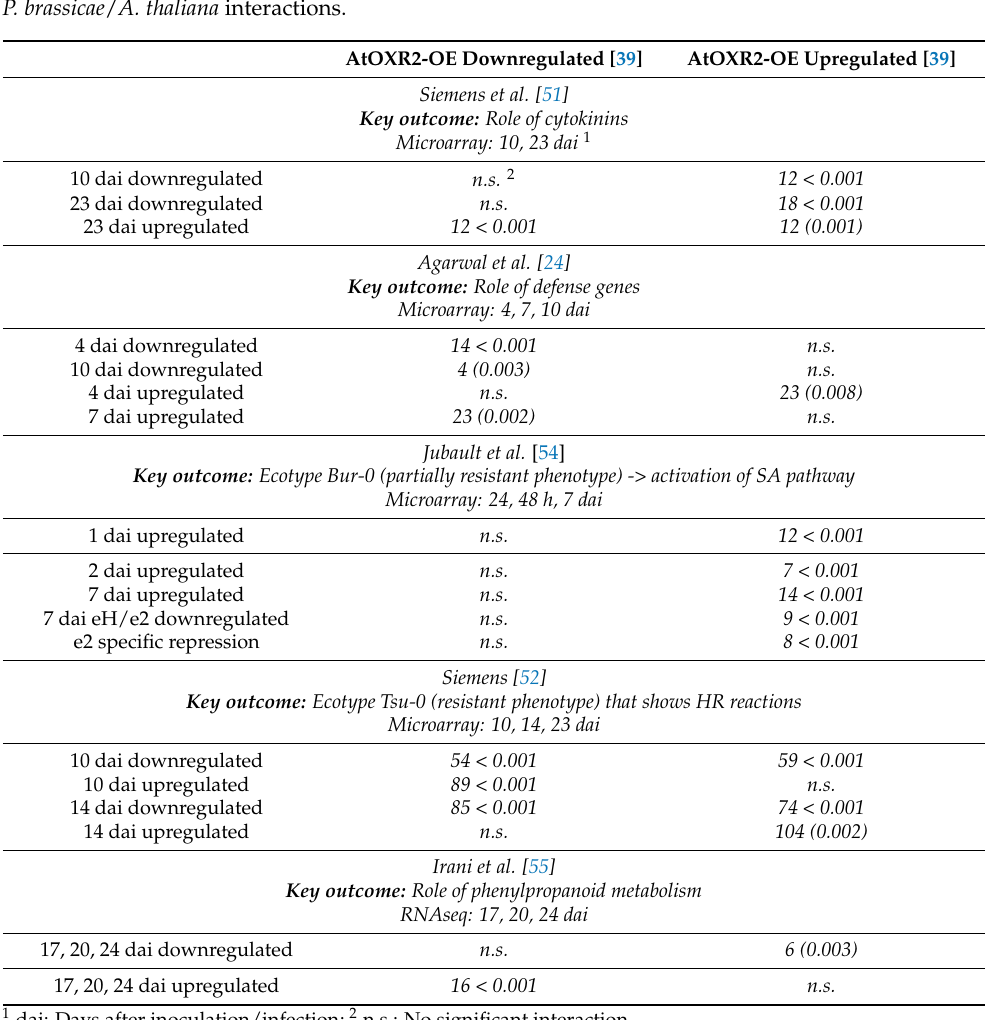
Table 2. Analysis of publicly available transcriptomic datasets for the expression of OXR2 in P. brassicae / A. thaliana